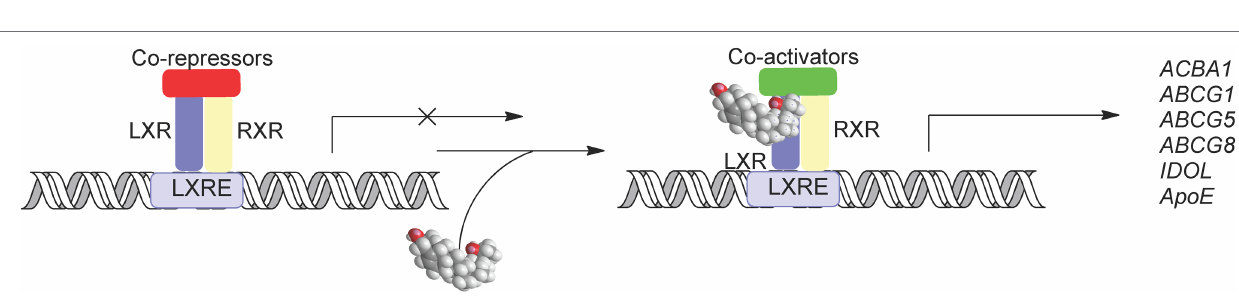
FIGURE 8 | Activation of LXRs by oxysterol. In the absence of ligand LXR-RXR heterodimers bind to the LXR response element (LXREs) and recruit co-repressors and supress gene expression. When activated by oxysterols co-repressors are replaced by co-activators leading to the expression of LXR target